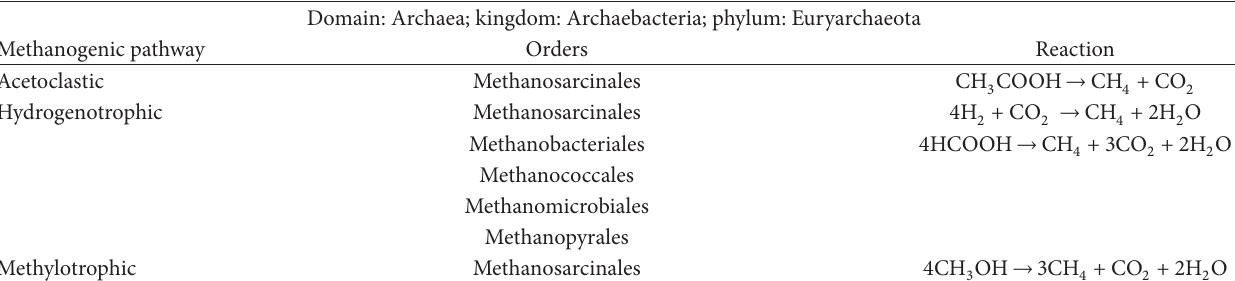
Table 6: Methanogenic pathways and microorganisms that are associated. Domain: Archaea; kingdom: Archaebacteria; phylum: